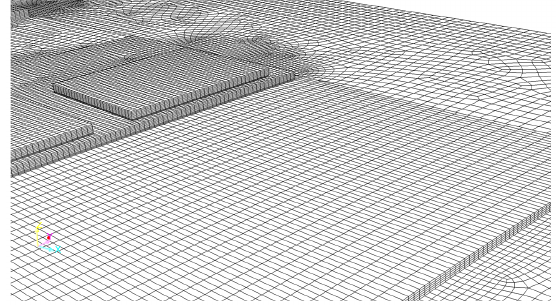
Figure 5. The surface mesh on silicon detectors.